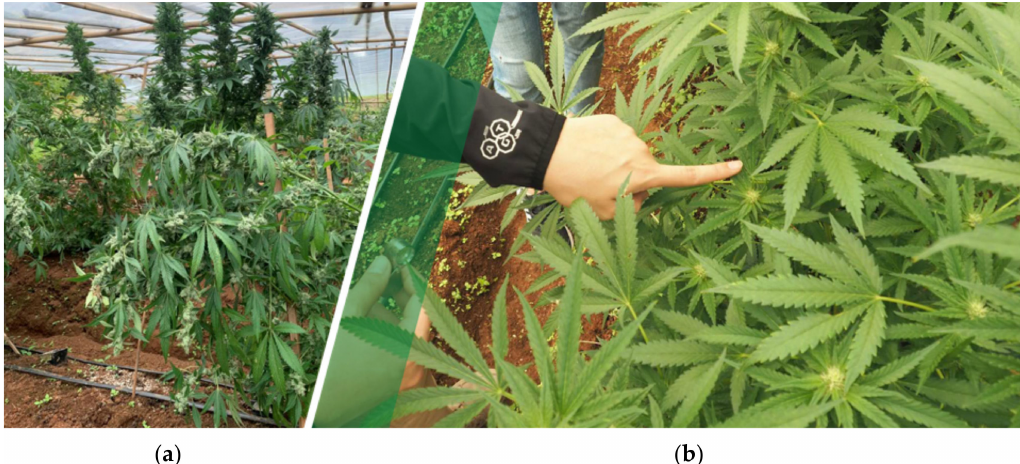
Figure 2. The cannabis plant var. Kees’ Old School Haze ® (available at https: // dutch-passion.com) ( a ) and their flower buds var. Gorilla Glue (available at http: // www.seedstockers.com) ( b